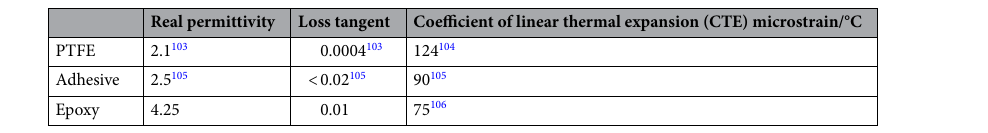
Table 2. Dielectric properties and coefficient of thermal expansion of PTFE, Adhesive and neat